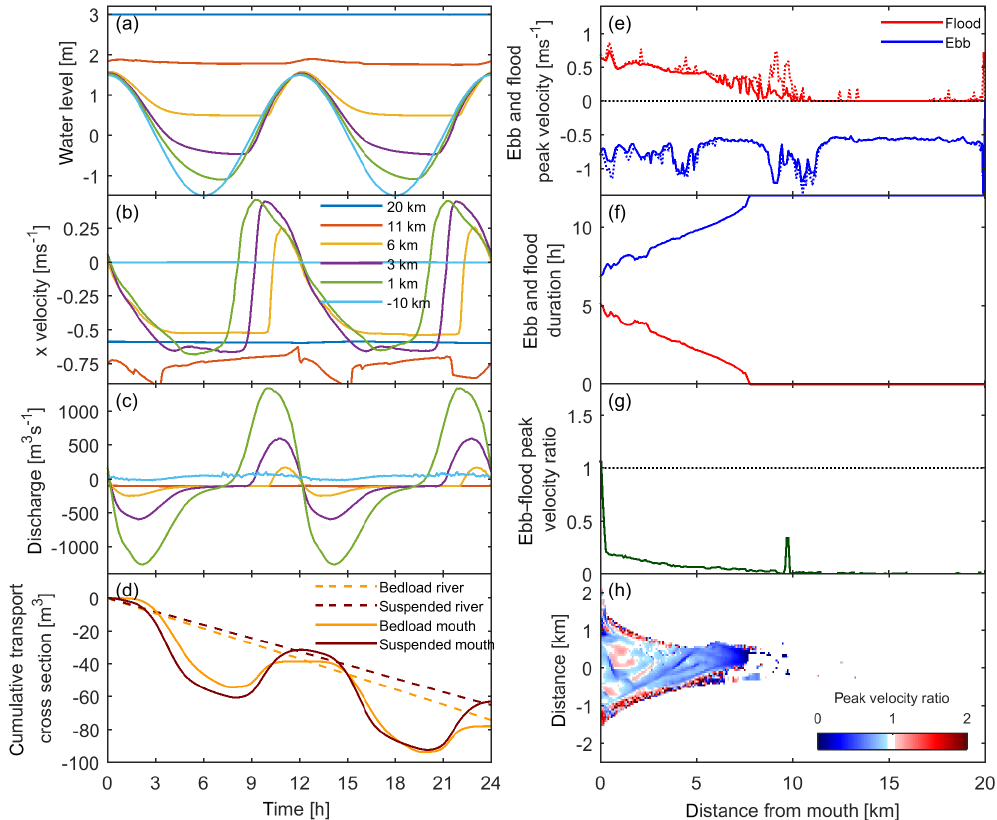
Figure 4. Hydrodynamics of the last day after 2000 years. The left panels show temporal variation in 1 day and the right panels show spatial variation along the estuary. (a) Water level, (b) streamwise flow velocity in the deepest channel with negative velocity towards the sea, (c) instantaneous discharge through the cross section and (d) cumulative sediment transport through the cross section showing no net difference between the upstream boundary and the coastline. (e) Maximum peak velocity for ebb and flood, (f) ebb and flood duration, (g) peak ebb and flood velocity ratio and (h) spatial pattern of peak velocity ratio showing flood-dominated shallow areas. The solid lines in panels (e) and (g) are based on streamwise velocity and the dotted line is based on velocity magnitude showing the effects of bends at